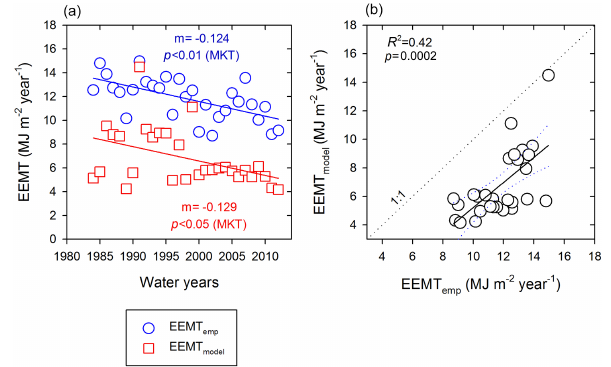
Figure 4. (a) EEMT emp and EEMT model showed similar significant decreasing trends from 1984 to 2012 of 1.2 and 1.3MJm − 2 yr − 1 ; (b) EEMT emp and EEMT model showed a significant linear correla- tion. Figure 5. Relationship between water availability and EEMT. Base-